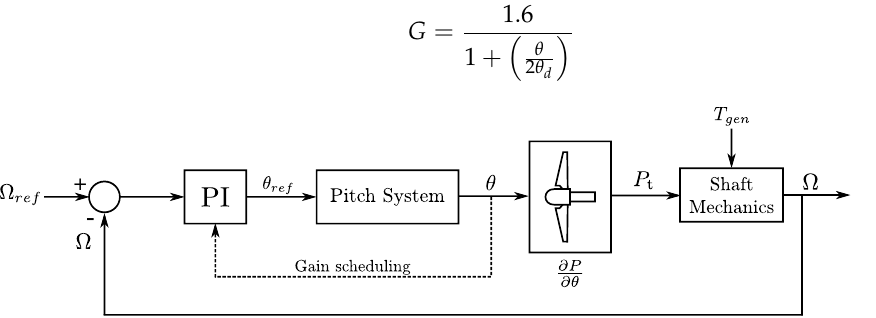
Figure 7. Pitch control of the wind turbine